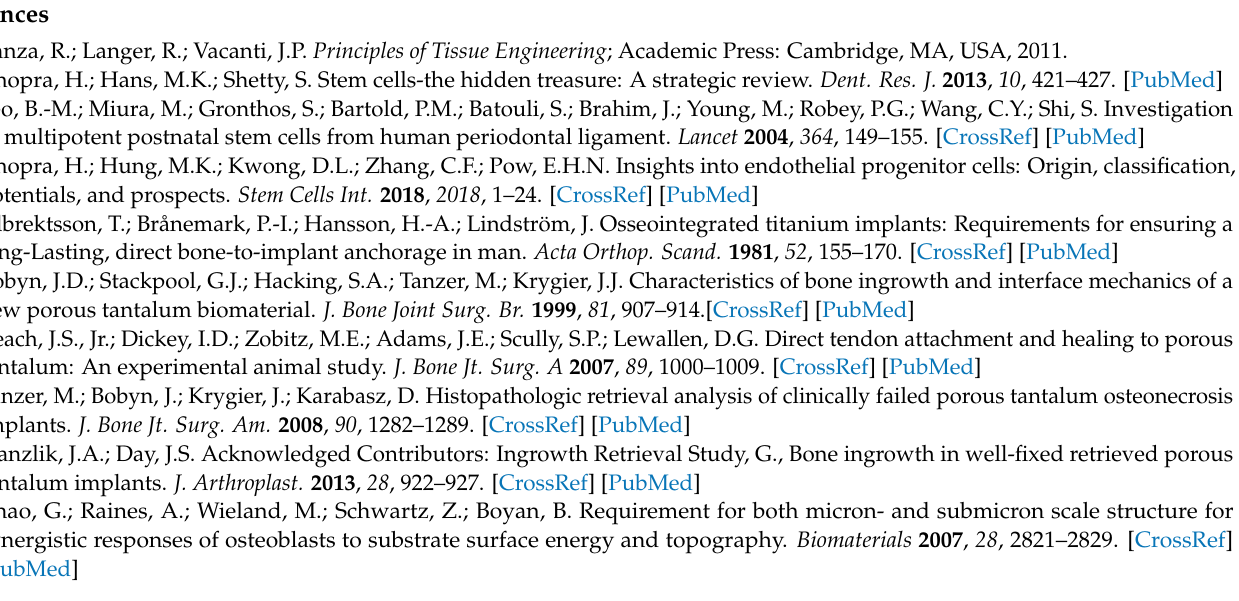
Table S3: Growth Curve of PDLCs and EPCs, either cultured alone (IP/IE) or both (IPE) on Ta